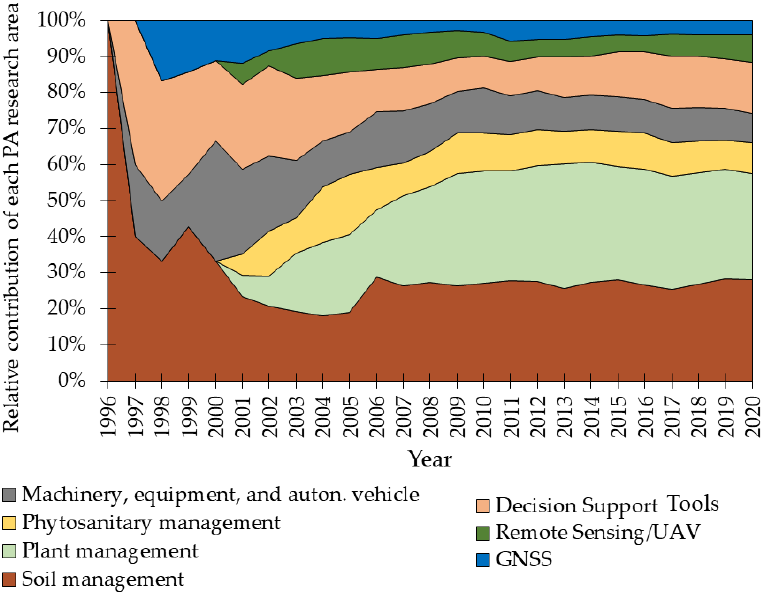
Figure 6. Temporal evolution of the number of publications in each PA research area in Brazil.